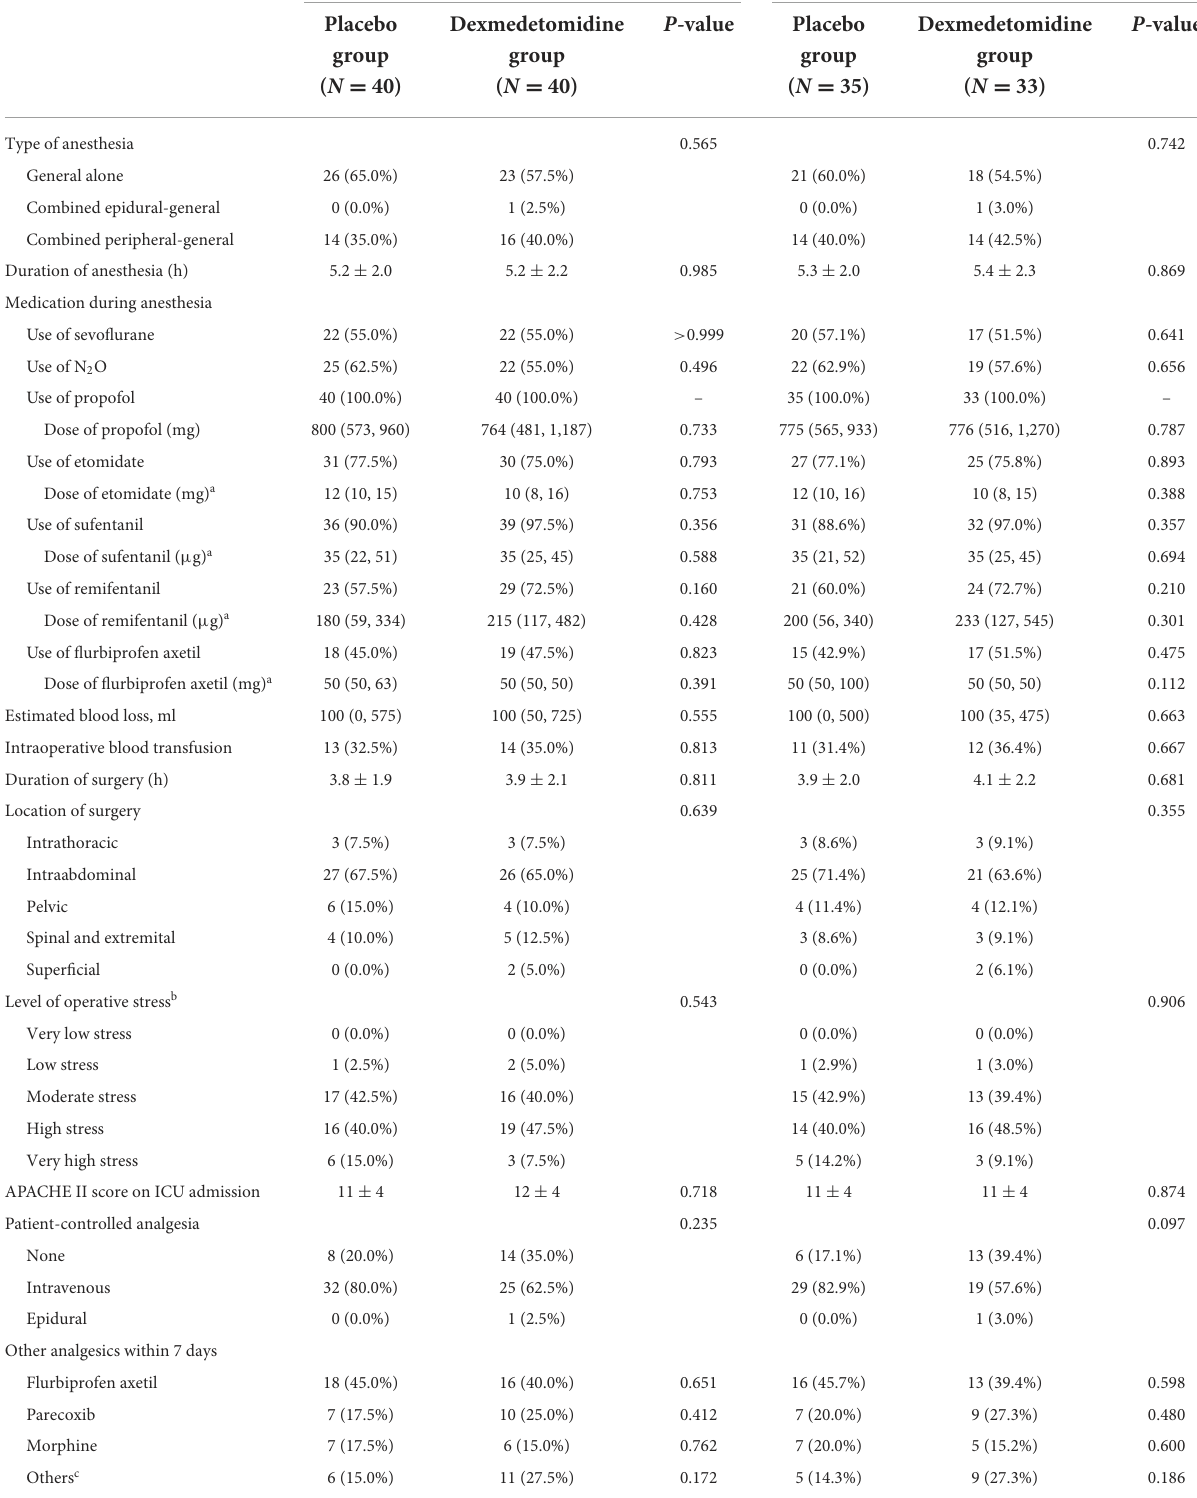
TABLE 2 Perioperative